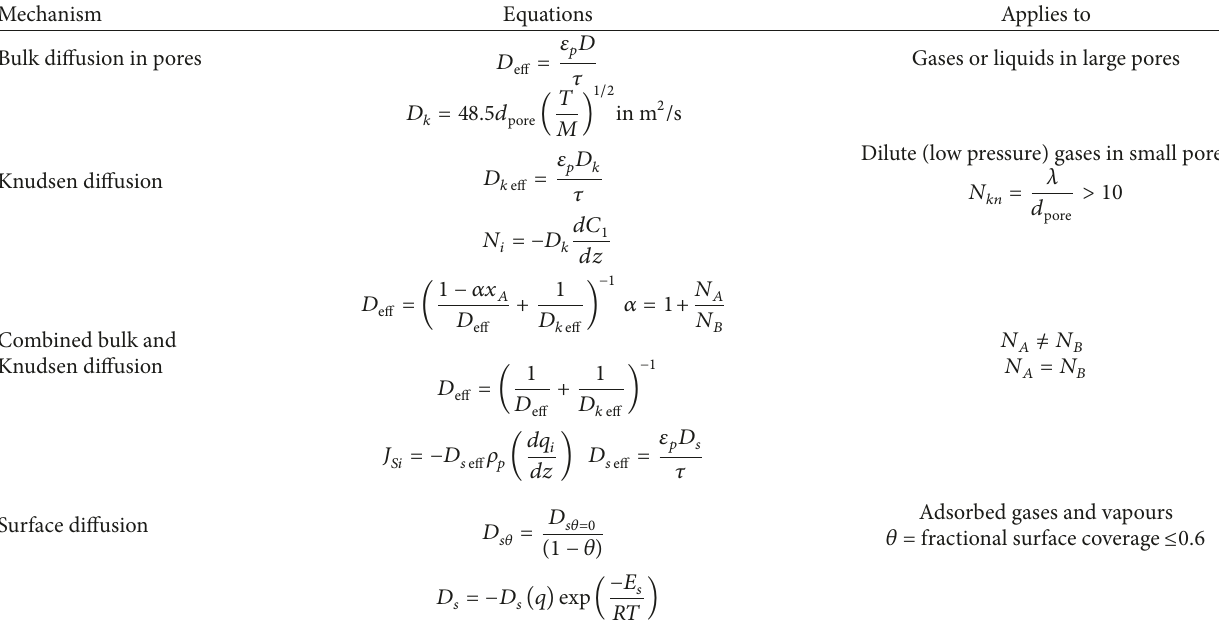
Table 3: Relations for diffusion in porous solids [18].